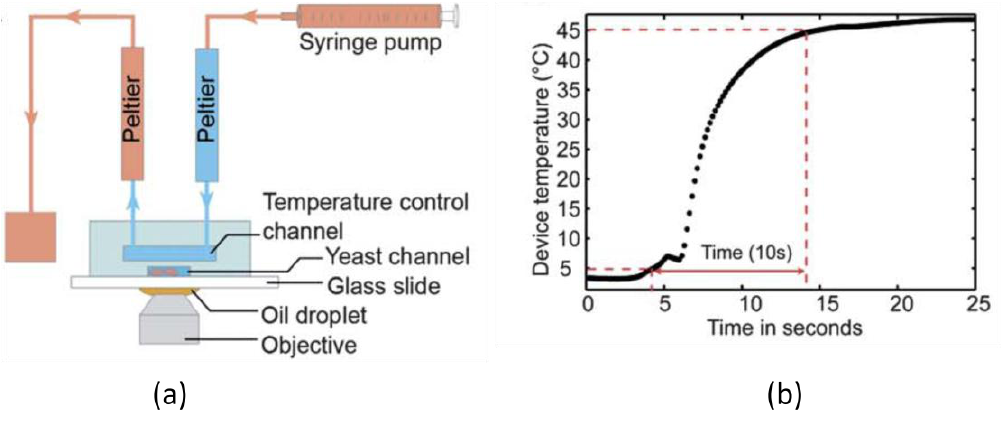
Figure 1. ( a ) A schematic representation of the control device: temperature is set by an external Peltier element; the yeast channel is placed below the temperature control channel ( b ) Temperature versus time plot showing a heating rate of 4 °C/s. Reprinted from [37], Copyright 2010, with permission from Elsevier.